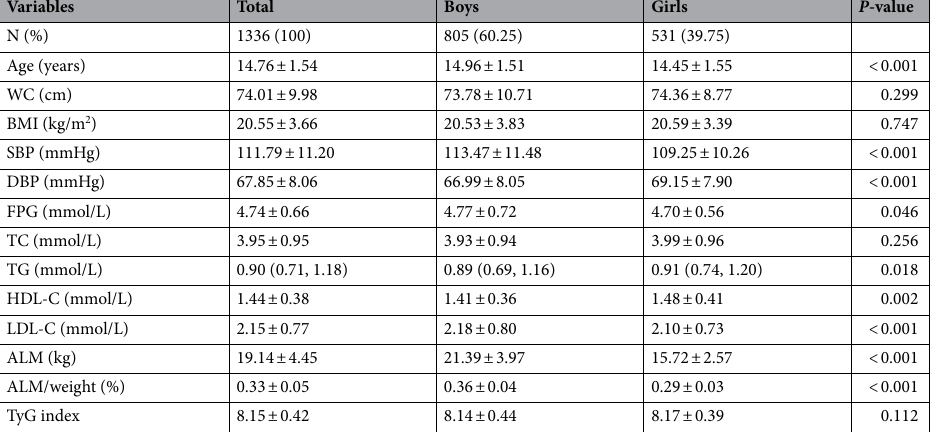
Table 1. Baseline characteristics of the study participants. Values are presented as means ± standard deviation, n (%) or median (interquartile ranges). WC waist circumference, BMI body mass index, SBP systolic blood pressure, DBP diastolic blood pressure, FPG fasting plasma glucose, TC total cholesterol, TG triacylglycerol, HDL-C high-density lipoprotein cholesterol, LDL-C low-density lipoprotein cholesterol, ALM appendicular lean mass, TyG index triglyceride-glucose index.